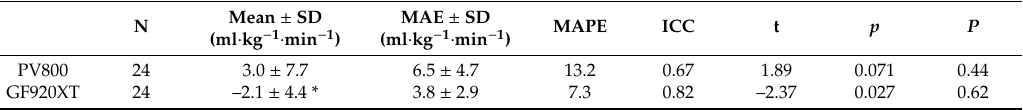
Table 2. Descriptive examination of the di ff erences between the measured VO 2max (CM3B) and the estimated VO 2max of the investigated sports watches. Arithmetic mean of estimated VO 2max ± standard deviation (Mean ± SD); mean absolute error ± standard deviation (MAE ± SD); mean absolute percentage error (MAPE); intraclass correlation coe ffi cient (ICC); test statistic (t); probability value ( p ); statistical power ( P ).